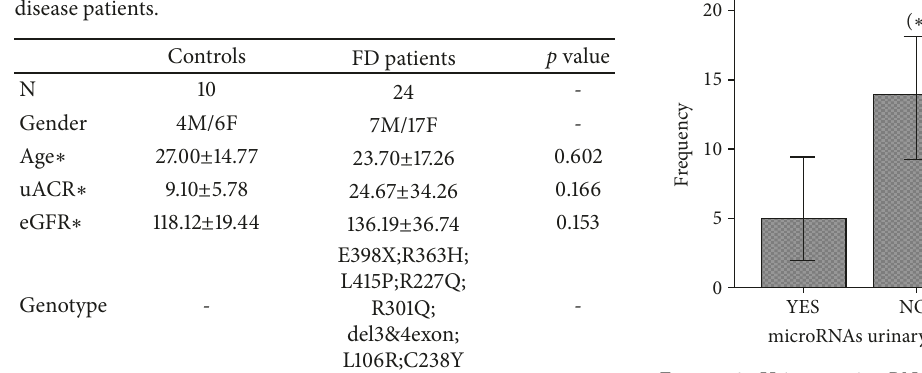
Figure 2: Urinary microRNAs excretion profile indicative of renal fibrosis according to degree of albuminuria in Fabry disease patients . Error bars indicates 95% confidence interval. ( ∗ ) p = <